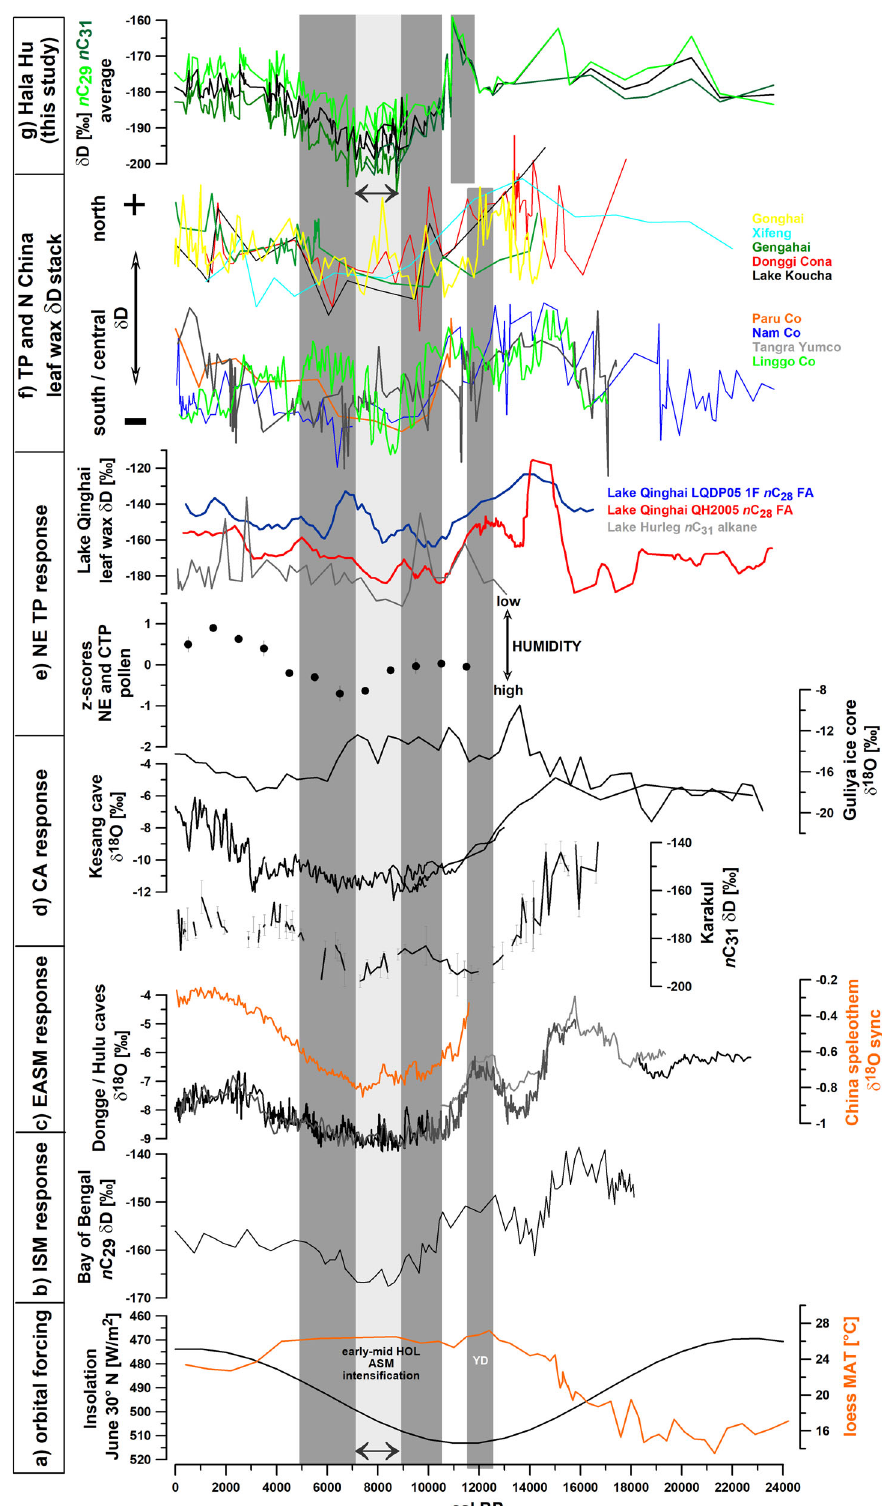
S3 – 3), in agreement with varying n C 23:1 to n C 27:1 ratios (Supplementary Fig. S3 – 1). Considering the present day algal consequence of the hydrological changes and a related change